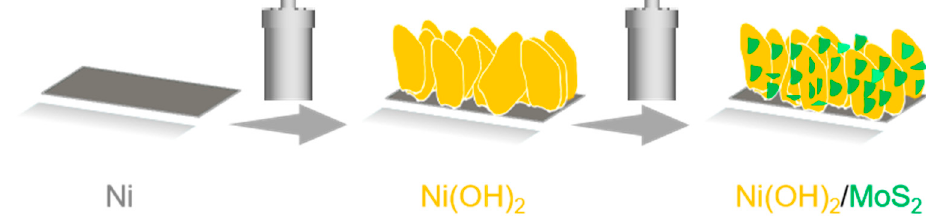
Figure 1. Schematic illustration of the synthesis.